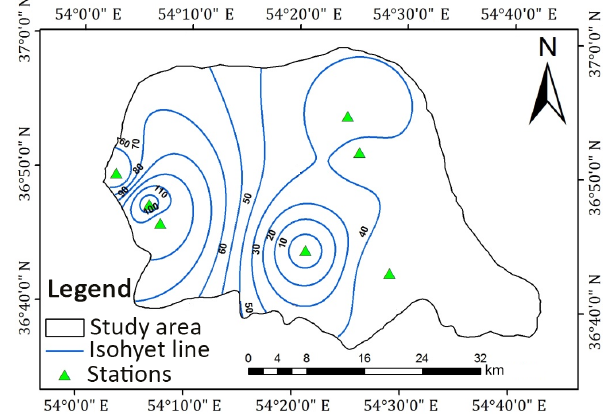
Figure 3. Spatial distribution of rainfall for the storm of September 2008 in the study